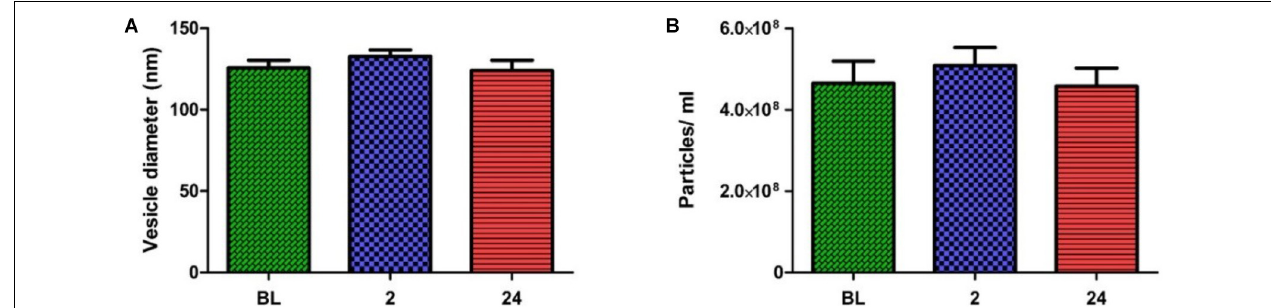
FIGURE 4 | Raw C t values for the spike-in control, cel-miR-39. Samples for all time points are represented as Mean ± SEM.